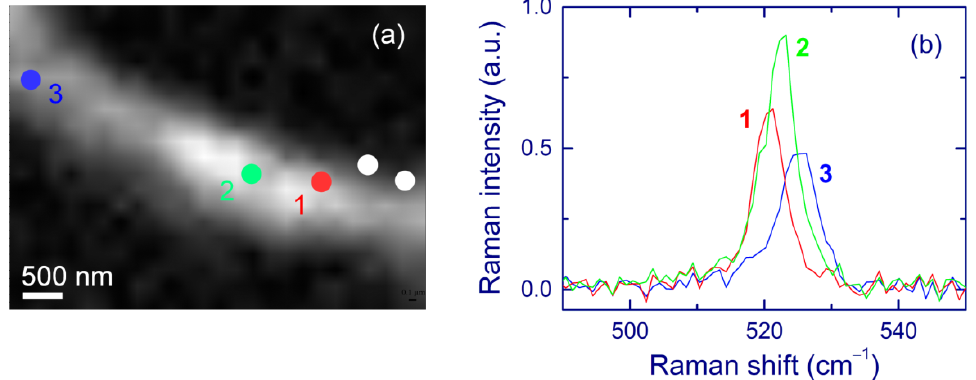
Figure 14. Raman characterization of the area shown in Figure 13a. ( a ) Raman map of Si-nc (integration from 515 to 530 cm –1 ) obtained with a 100× objective and steps of 0.2 μ m. Brighter areas correspond to stronger Raman signals. The white circles indicate the positions of two holes used as the reference points. ( b ) Raman spectra in positions 1, 2, and 3 indicated in ( a ). Position 1 corresponds to the surface Si-nc shown in Figure